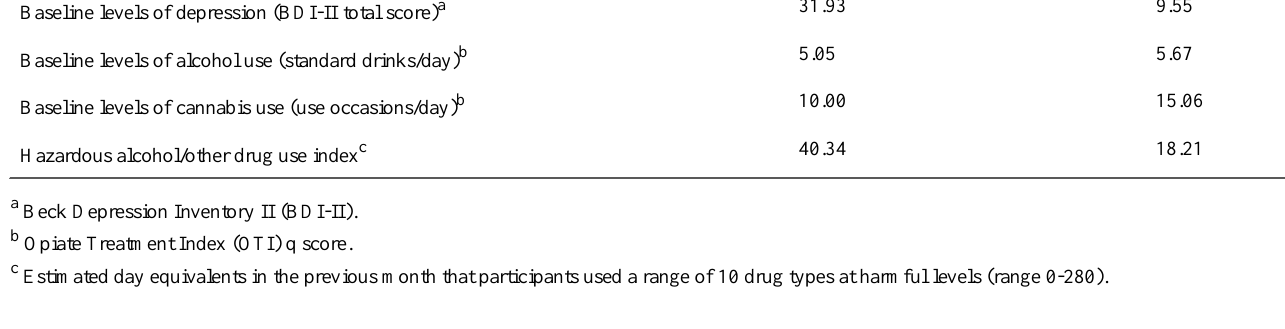
Table 2. Baseline presenting symptom